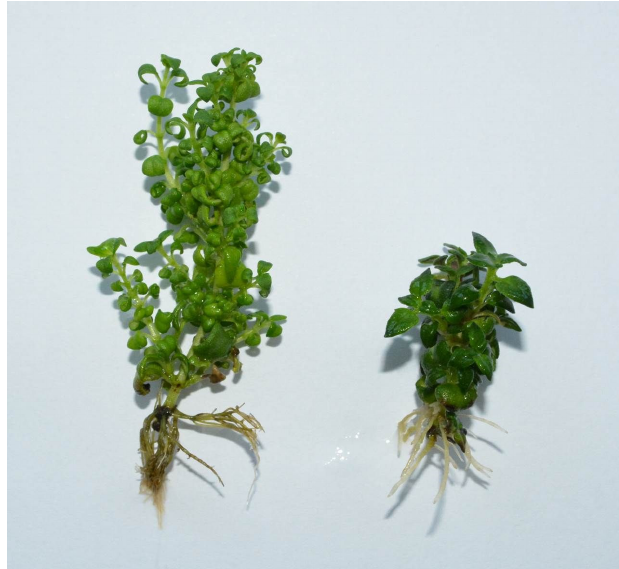
Figure 1. Representative flow cytometric histograms of nuclear DNA contents of T. vulgaris . ( A ) diploid reference plant and internal standard Zea mays * and ( B ) tetraploid originated from clone No. 8 and standard Zea mays *.